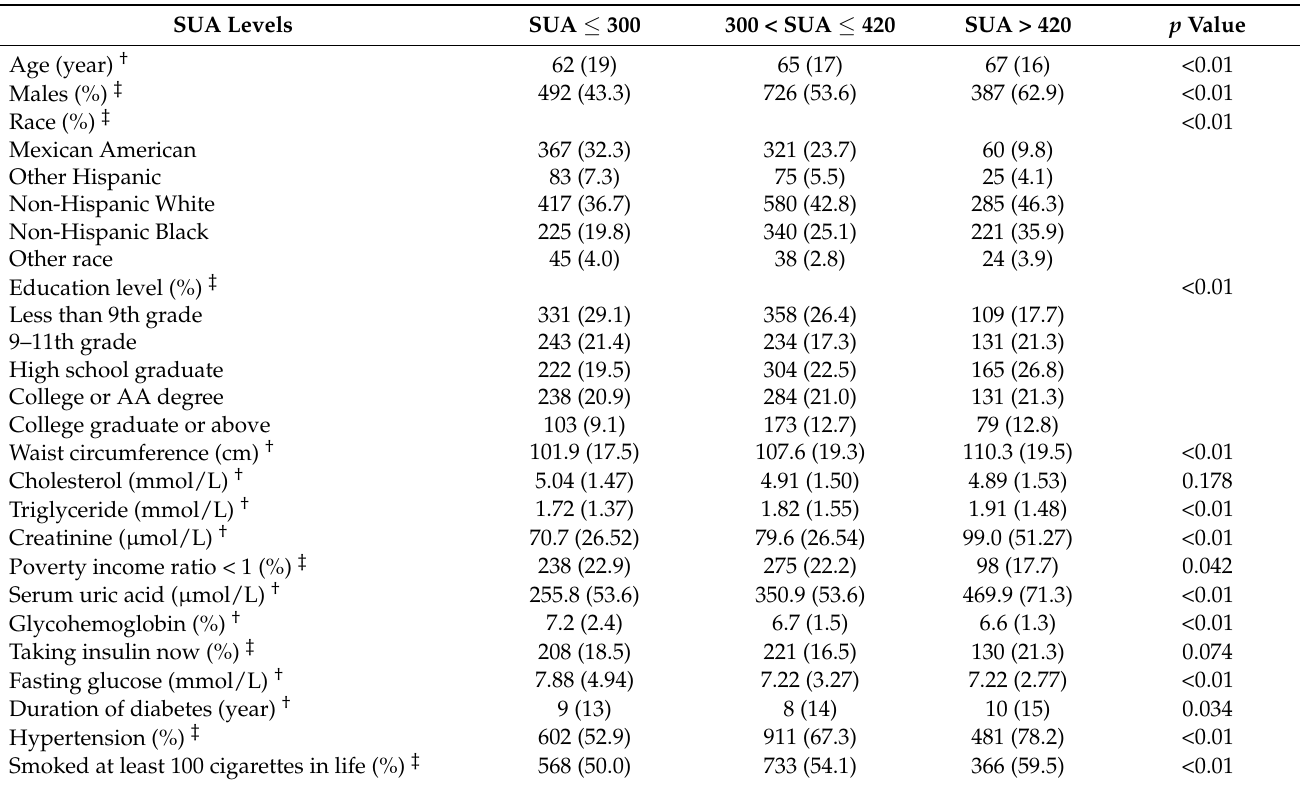
Table 1. Clinical characteristics of the involved diabetes patients for the analysis of cardiovascular disease ( n =